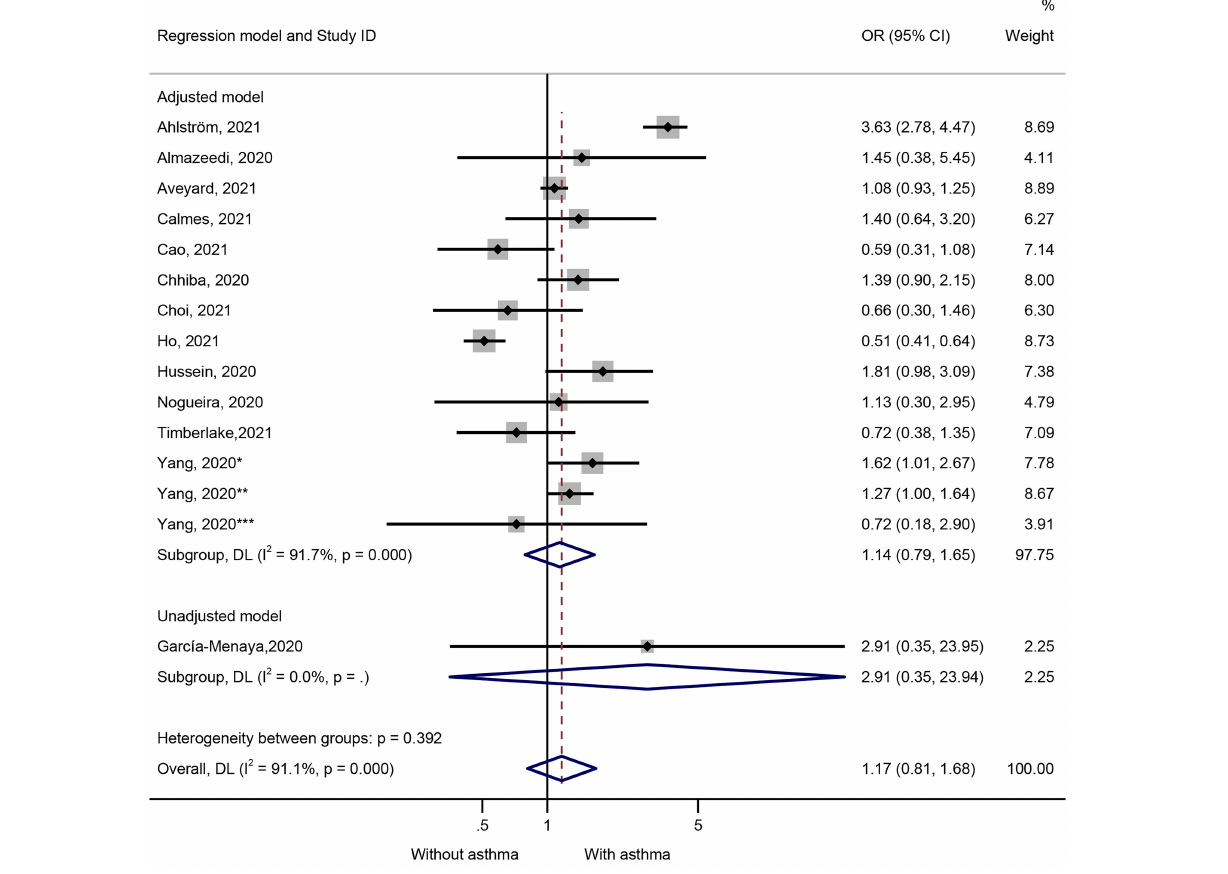
sensitivity analysis showed that no single study influenced the results ( Supplementary Figure 1